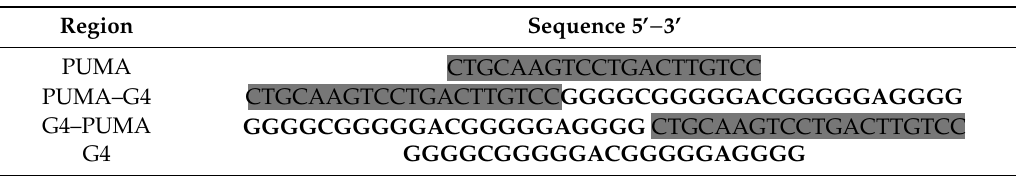
Table 1. Sequences cloned into luciferase promoter regions into yeast isogenic reporter strain (PUMA sequence – highlighted by grey, G-repeats –